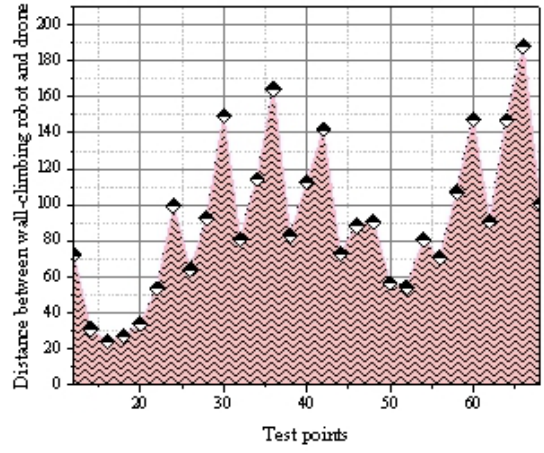
Fig. 6. For complex threats, the distance change between the wall-climbing robot and the drone